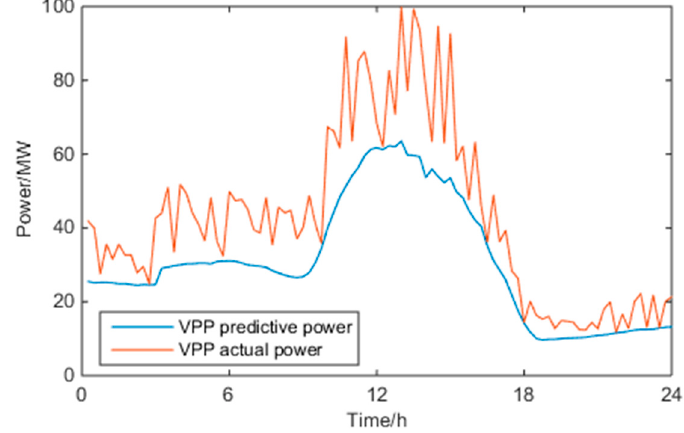
Figure 10. VPP predictive power and actual power of typical scenario 13.